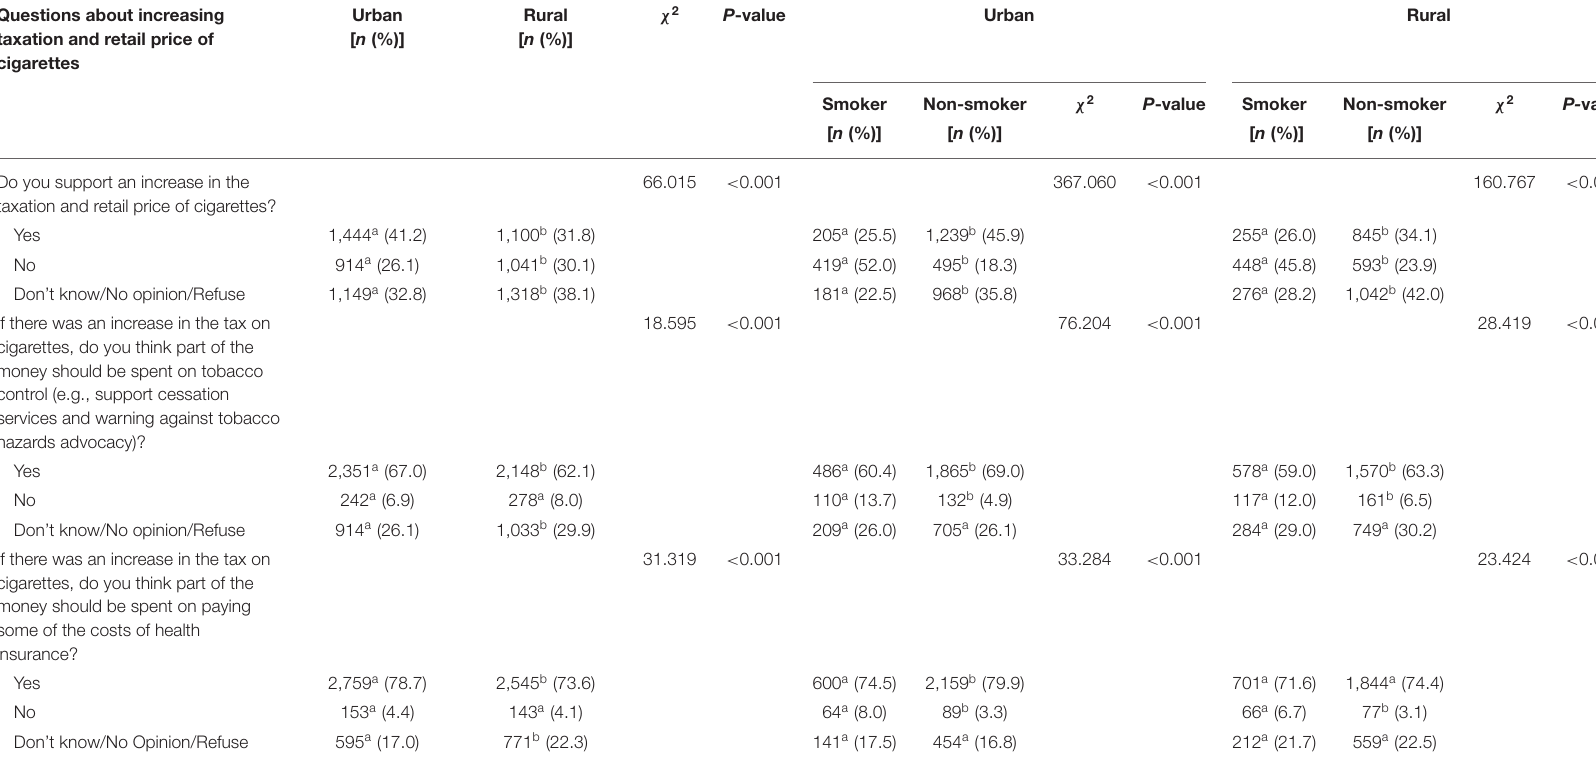
TABLE 6 | Responses to tobacco taxation among the urban and rural elderly in